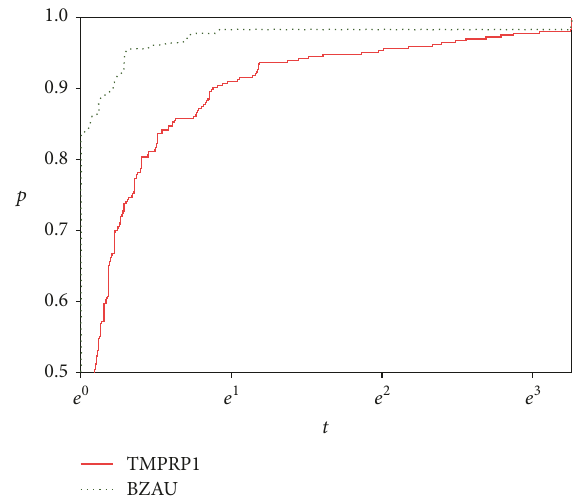
Figure 1: Performance profiles based on the number of iterations.